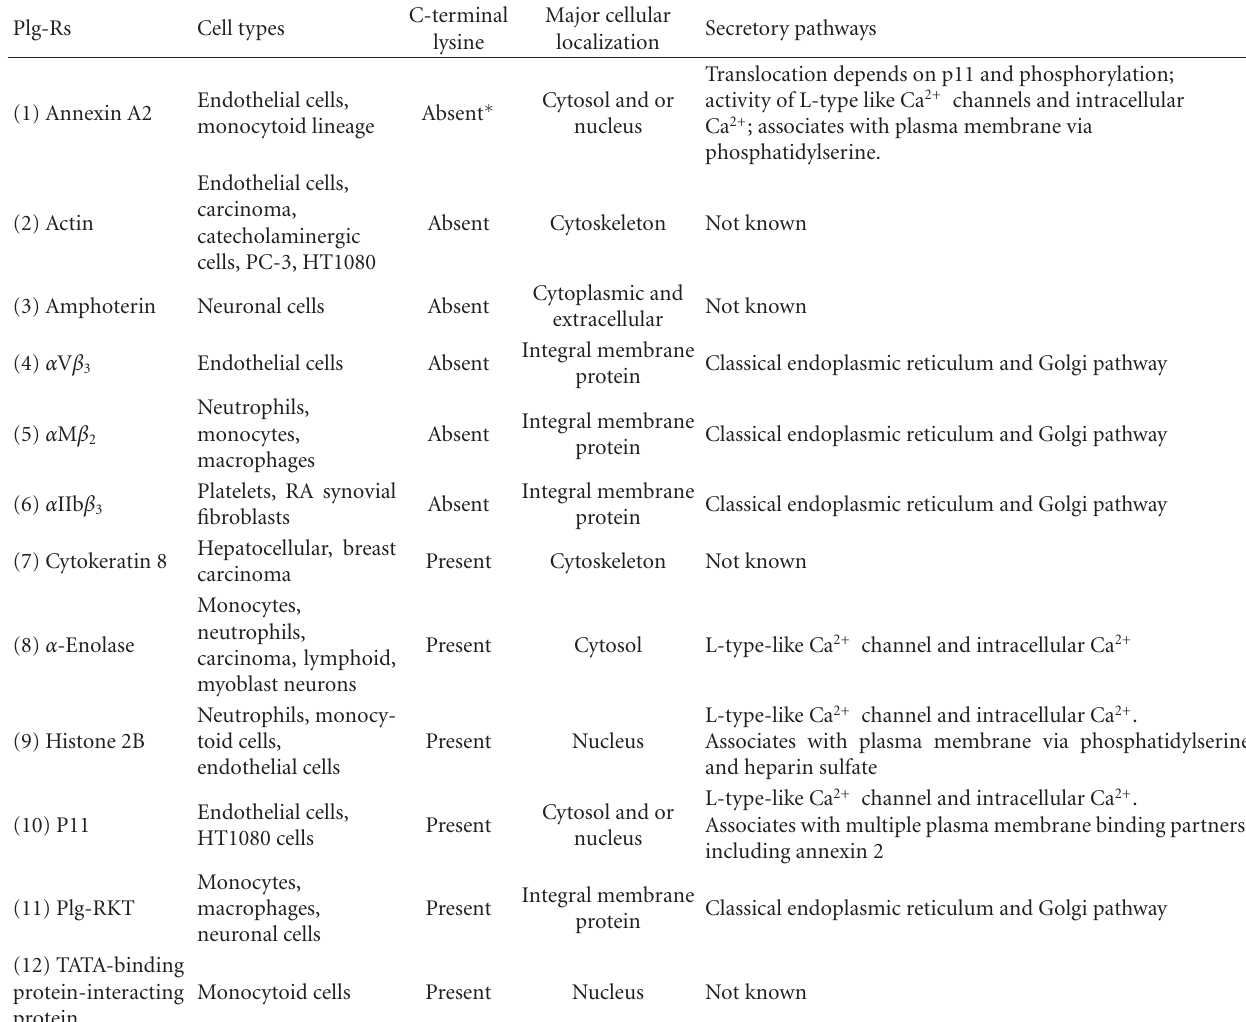
Table 1: Plg-Rs on various cell